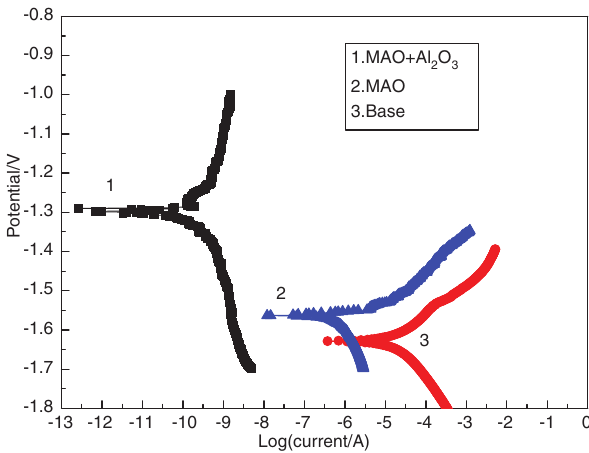
O MAO coating on the corrosion 2 3